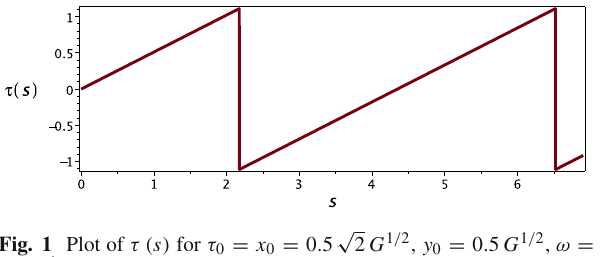
Fig. 1 Plot of τ ( s ) for τ 0 = x 0 = 0 . 5 1